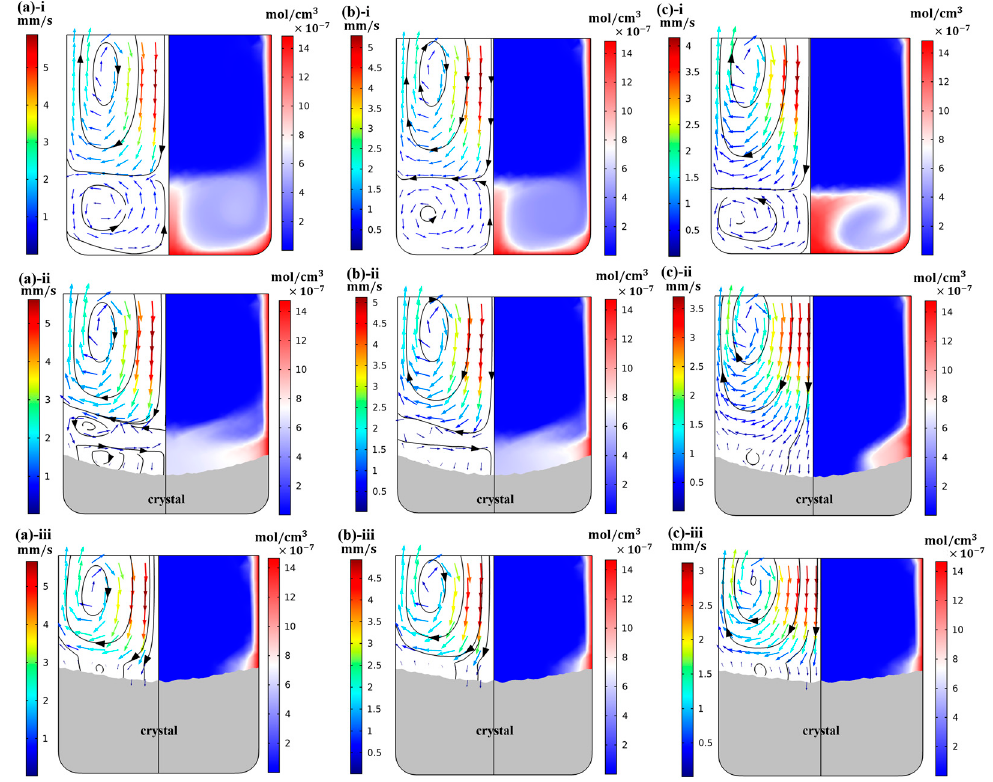
Figure 7. The direction and intensity of melt convection velocity (left) and oxygen distribution (right) in the silicon melt when the current magnitude is: ( a ) 1 A, ( b ) 10 A, and ( c ) 20 A at ( i ) the beginning, ( ii ) the 45th minute, and ( iii ) the 90th minute of the crystallization ( ii ) the 45th minute, and ( iii ) the 90th minute of the crystallization stage.